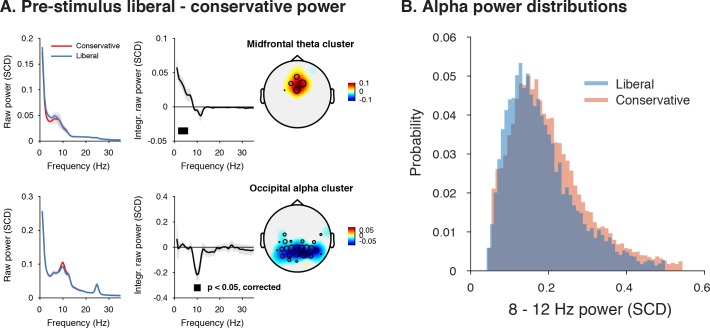
Adopting a liberal decision bias is reflected in increased midfrontal theta and suppressed pre-stimulus alpha power.(A) Significant clusters of power modulation between liberal and conservative in a pre-stimulus window between −1 and 0 s before trial onset. When performing a cluster-based permutation test over all frequencies (1–35 Hz) and electrodes, two significant clusters emerged: theta (2–6 Hz, top), and alpha (8–12 Hz, bottom). Left panels: raw power spectra of pre-stimulus neural activity for conservative and liberal separately in the significant clusters (for illustration purposes), Middle panels: Liberal – conservative raw power spectrum. Black horizontal bar indicates statistically significant frequency range (p<0.05, cluster-corrected for multiple comparisons, two-sided). Right panels: Corresponding liberal – conservative scalp topographic maps of the pre-stimulus raw power difference between conditions for EEG theta power (2–6 Hz) and alpha power (8–12 Hz). Plotting conventions as in Figure 3. Error bars, SEM across participants (N = 15). (B) Probability density distributions of single trial alpha power values for both conditions, averaged across participants.